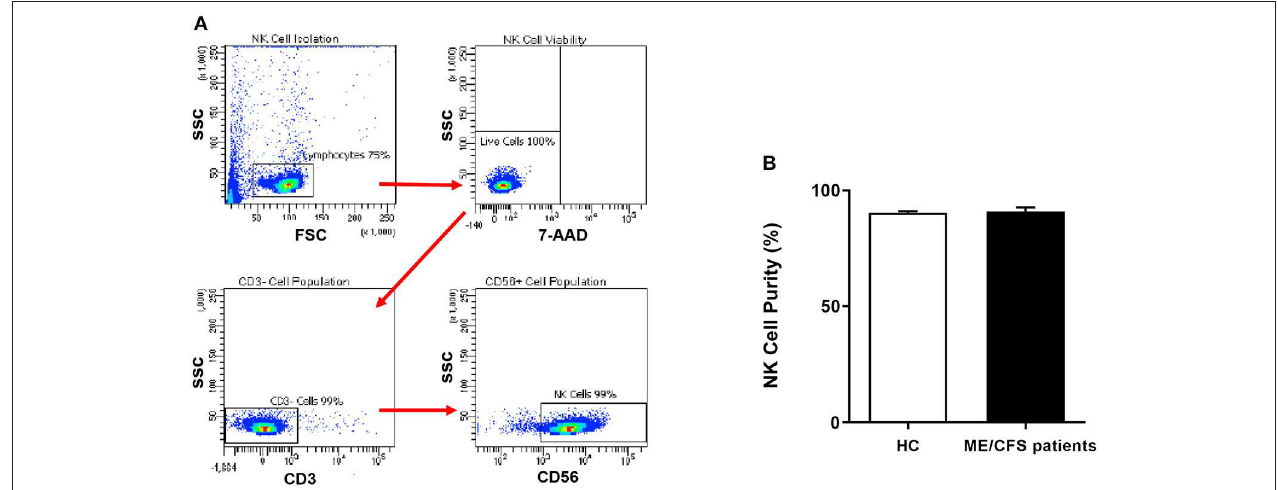
FIGURE 1 | Natural Killer cell purity. (A) Gating strategy used to identify NK cells. Representative flow cytometry plots from the PBMCs of one of the study participants. The lymphocytes were live gated during acquisition using the side and forward scatter dot plot display and then single and dead cells were excluded. Furthermore, by using the negative and positive gating strategies, CD3 − as well as CD56 + lymphocyte populations were identified. (B) Bar graphs representing isolated NK cell purity for HC and ME/CFS patients. Data presented as mean ± SEM. HC = 90.34% ± 0.6782 and ME/CFS = 90.9% ± 1.695. 7-AAD, 7-amino-actinomycin; ME/CFS, myalgic encephalomyelitis/chronic fatigue syndrome; FSC, forward scatter; HC, healthy controls; NK cell, natural killer cell; SSC, side scatter.